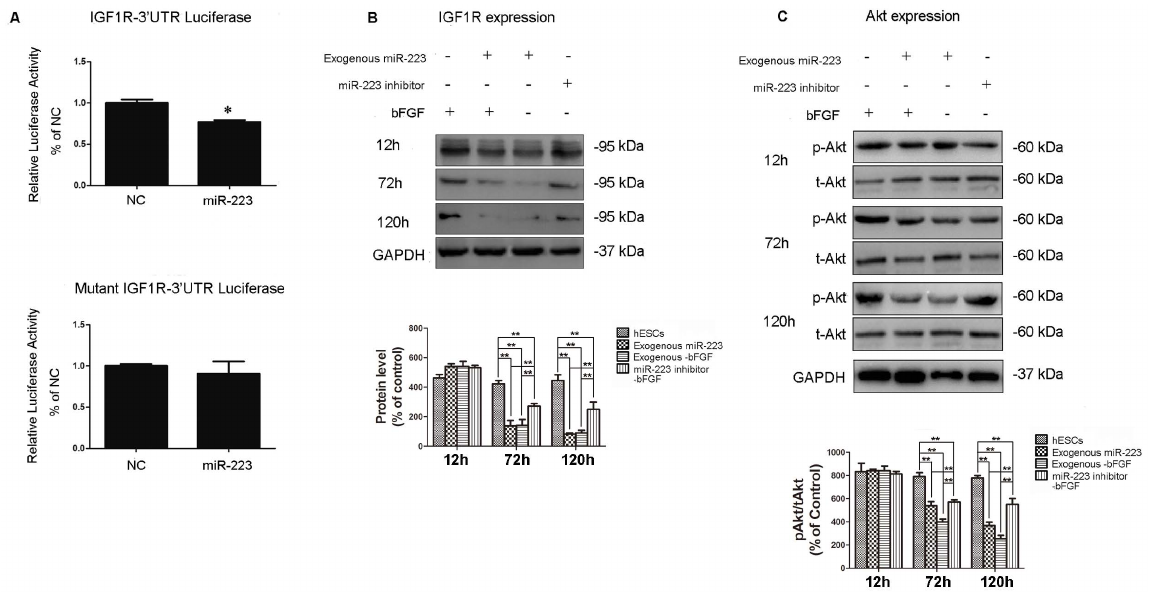
Figure 3. MiR-223 regulates hESCs differentiation likely via IGF-1R/Akt. ( A ) hESCs were infected with lentiviruses expressing miR-223 and wild type IGF-1R-3 9 UTR or a mutant IGF-1R-3 9 UTR construct. After 48 h, luciferase (Luc) activity was assayed. Data are presented as the mean 6 SEM of the percentage of luciferase activity detected in control cells (* p , 0.05; n=4). Western blotting was performed to detect levels of IGF-1R ( B ) and phosphorylated Akt (p-Akt) and total Akt (t-Akt) ( C ) 12, 72, and 120 h after withdrawal of bFGF for the indicated groups. NC indicates the mock- vehicle group and GAPDH was used as a loading control. Protein bands were semi-quantified using imaging analysis software. Data are expressed as the mean 6 SD and are representative of the three independent experiments that were performed. *p , 0.05, **p , 0.01, n=3.